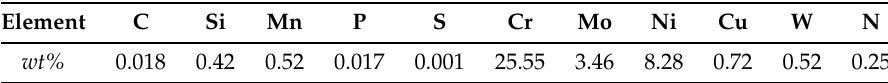
Table 1. Chemical composition of 2507 SDSS.